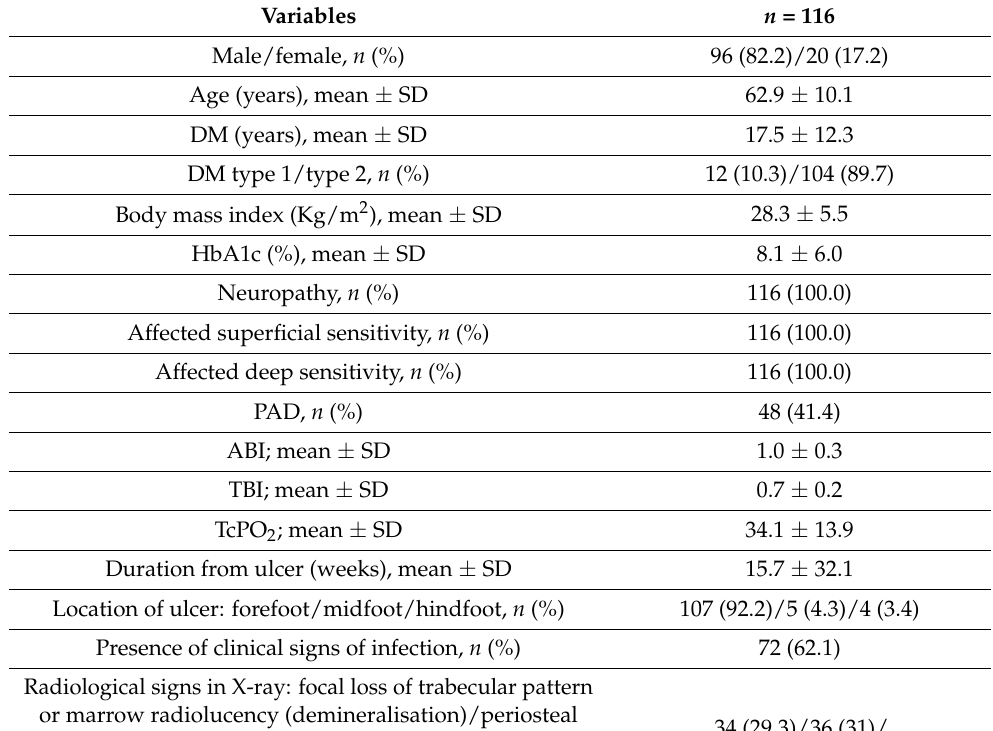
Table 1. Participants’ baseline clinical